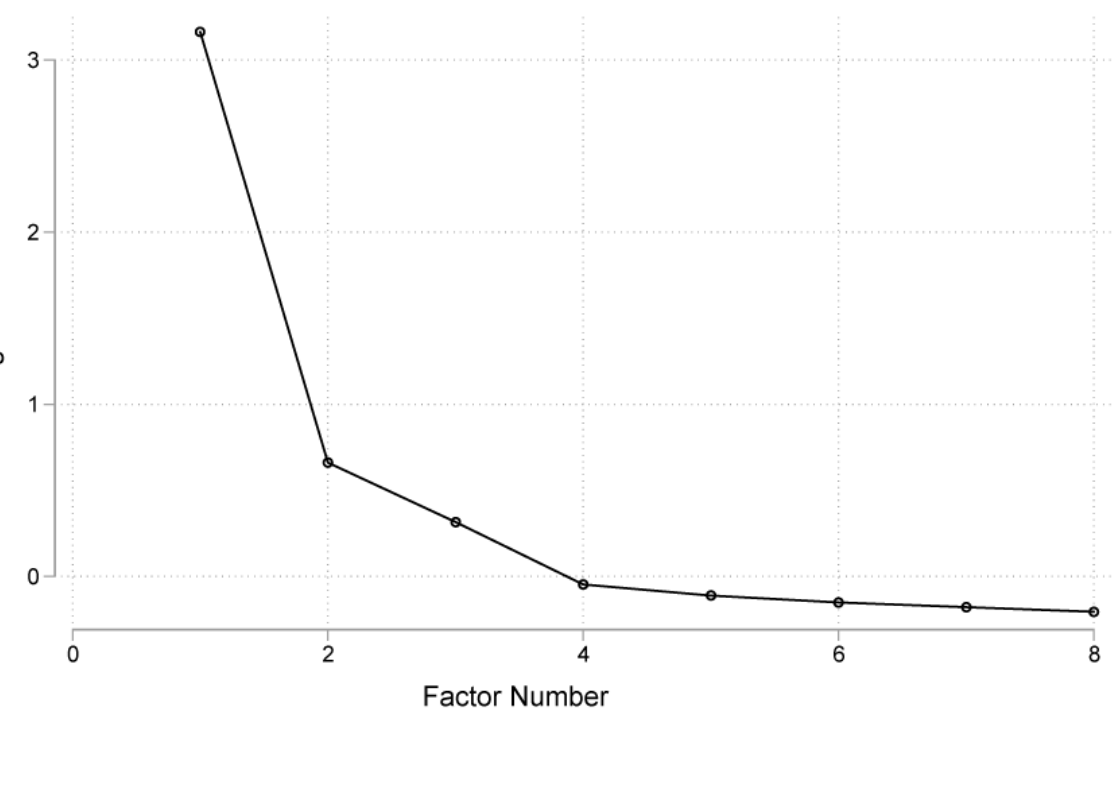
Kaiser-Meyer-Olkin valueFactor loadingC-eHEALS items